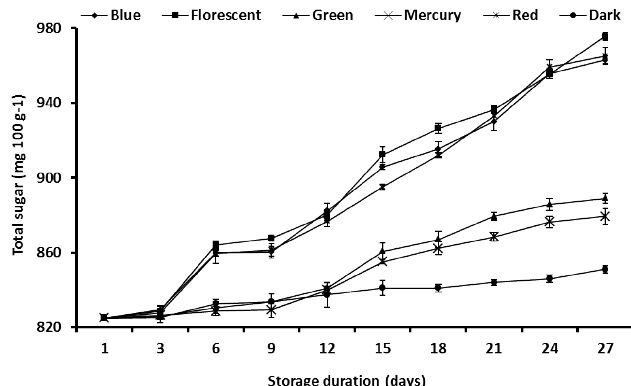
Fig. 2: Effect of different light sources on total sugar. Vertical bars show ±SE of means (n=3). The interaction between storage duration and light sources was significantly different at p ≤ 0.05.